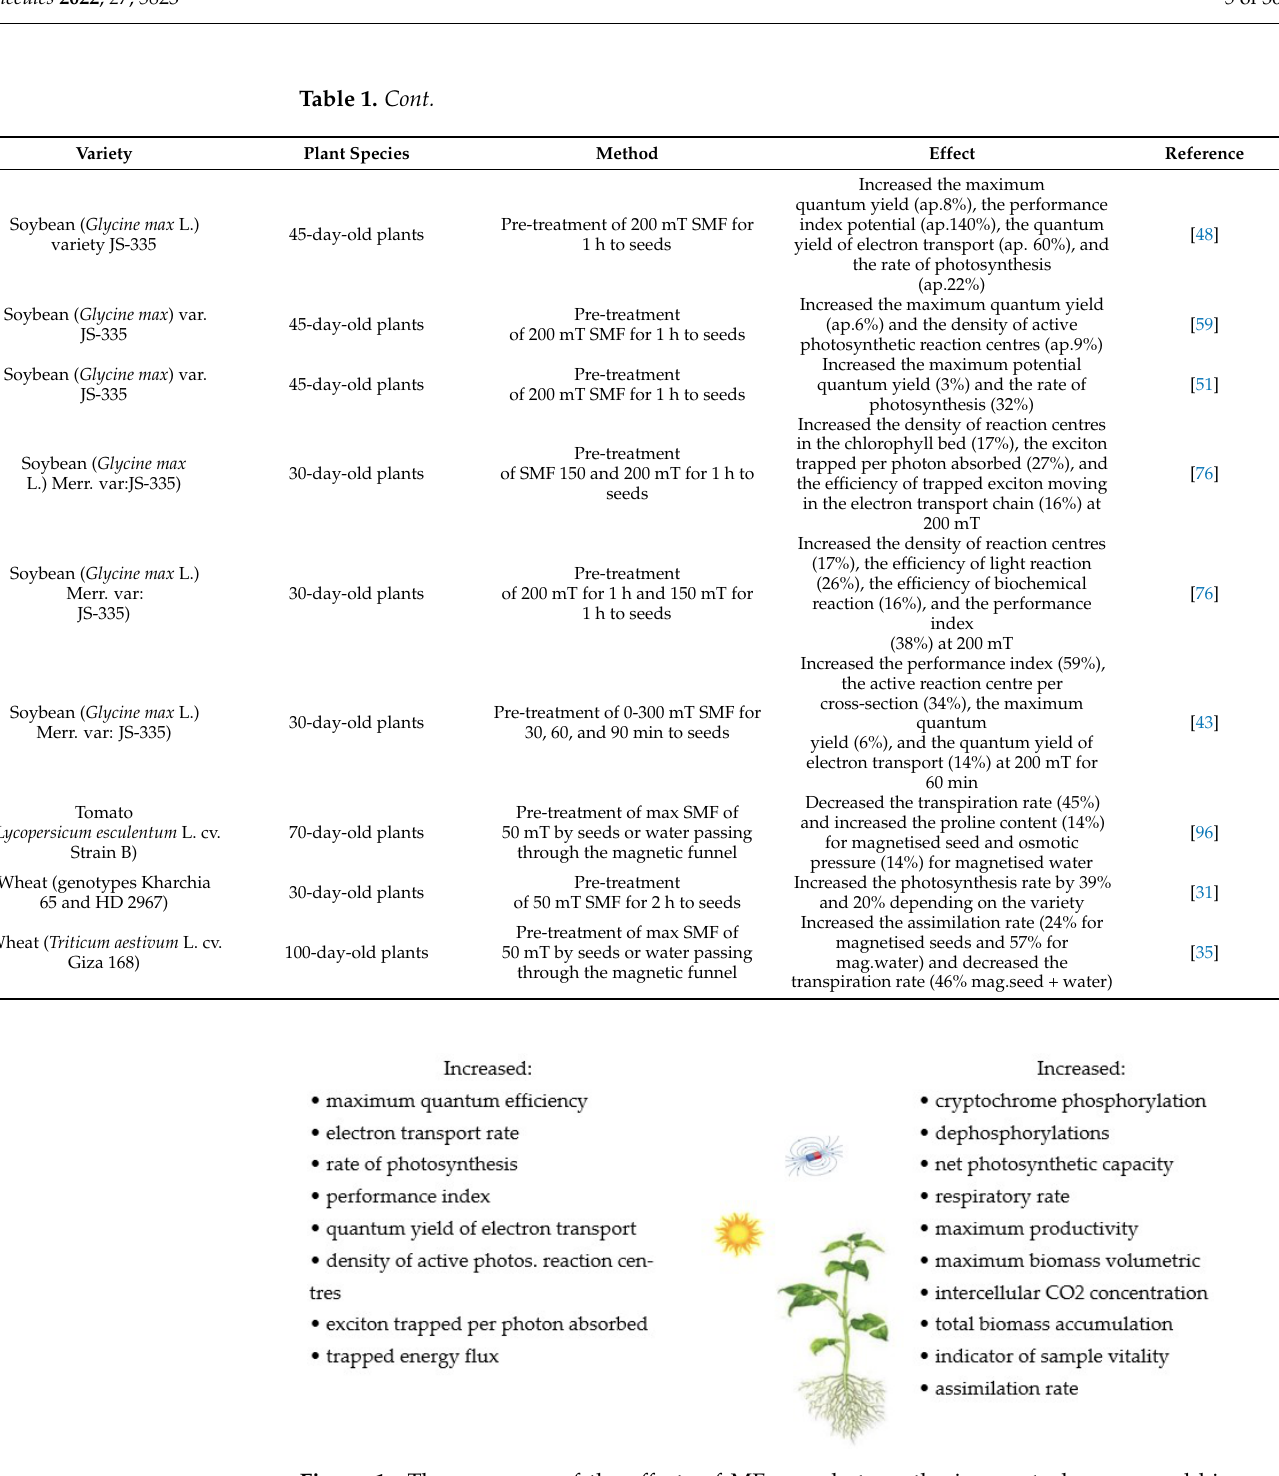
Figure 1. The summary of the effects of MFs on photosynthesis, cryptochromes, and biomass productivity [46,49]. Copyright Bioresour. Technol . 2019 , 292 , 121945. Copyright Int. J. Mol. Sci . 2021 , 22 , 9353.